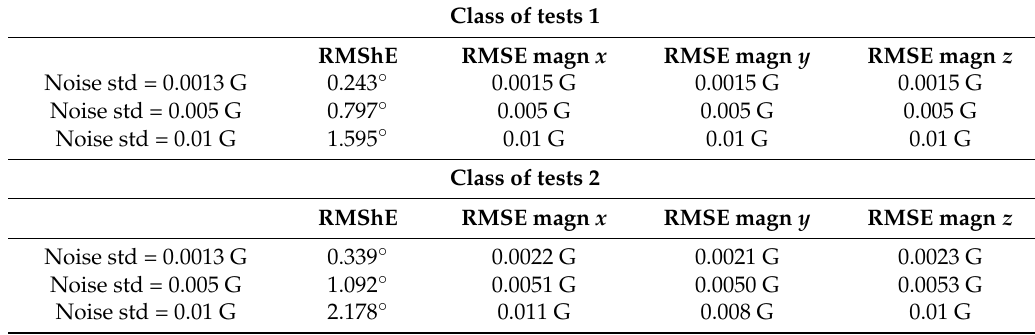
Table 1. Errors along the three magnetometer axes and heading errors in class of tests 1 and 2, respectively. The errors were reported in terms of RMSE as a function of the standard deviation of the Gaussian noise added to the simulated signals. Noise std indicates the standard deviation added to the simulated magnetometer data. RMShE indicates Root Mean Square heading Error. RMSE magn x , RMSE magn y , RMSE magn z , indicate the Root Mean Square Error along x, y, z axes, respectively, of the